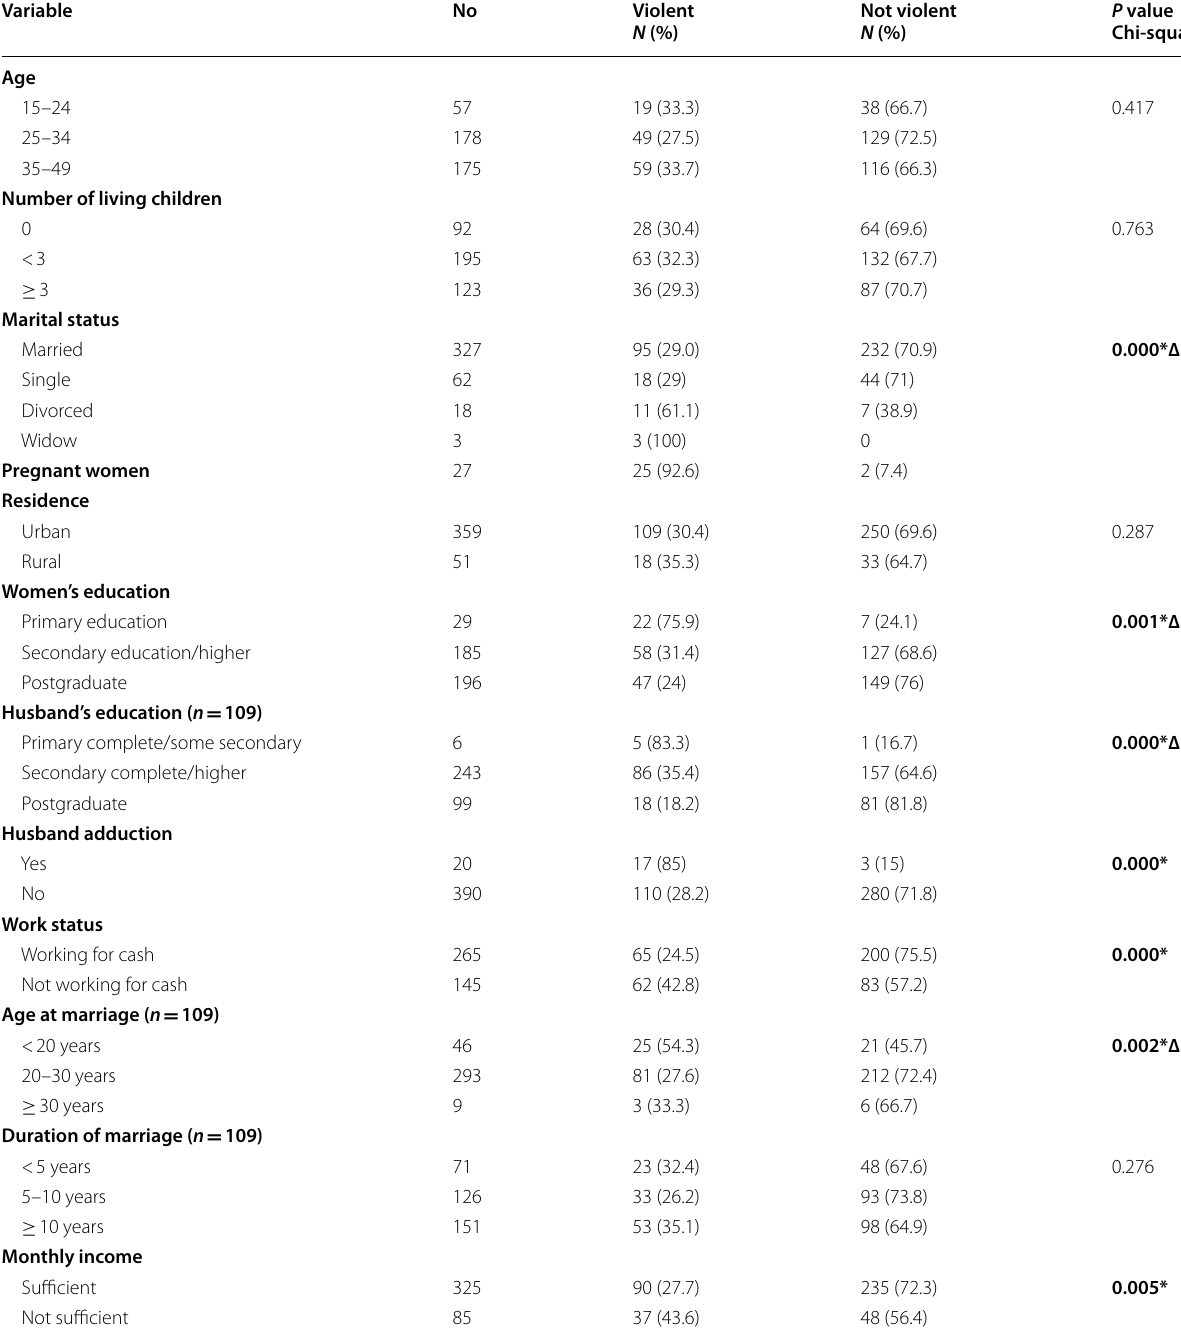
Table 3 The relationship between the demographic characteristics and domestic violence among the studied women in eight governorates, Egypt, 2020 ( n =